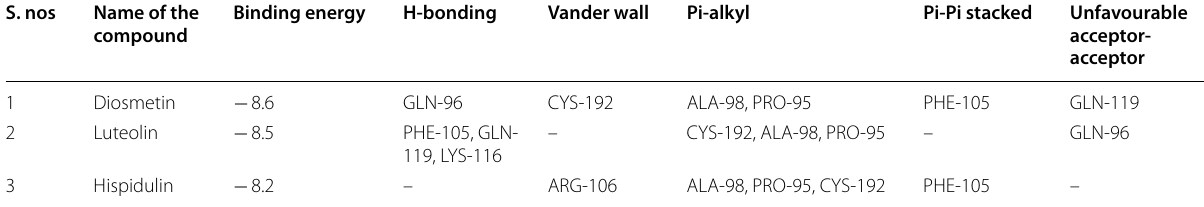
Table 3 Types of bonding and interacting amino acids of V2R with top five compounds S. nos